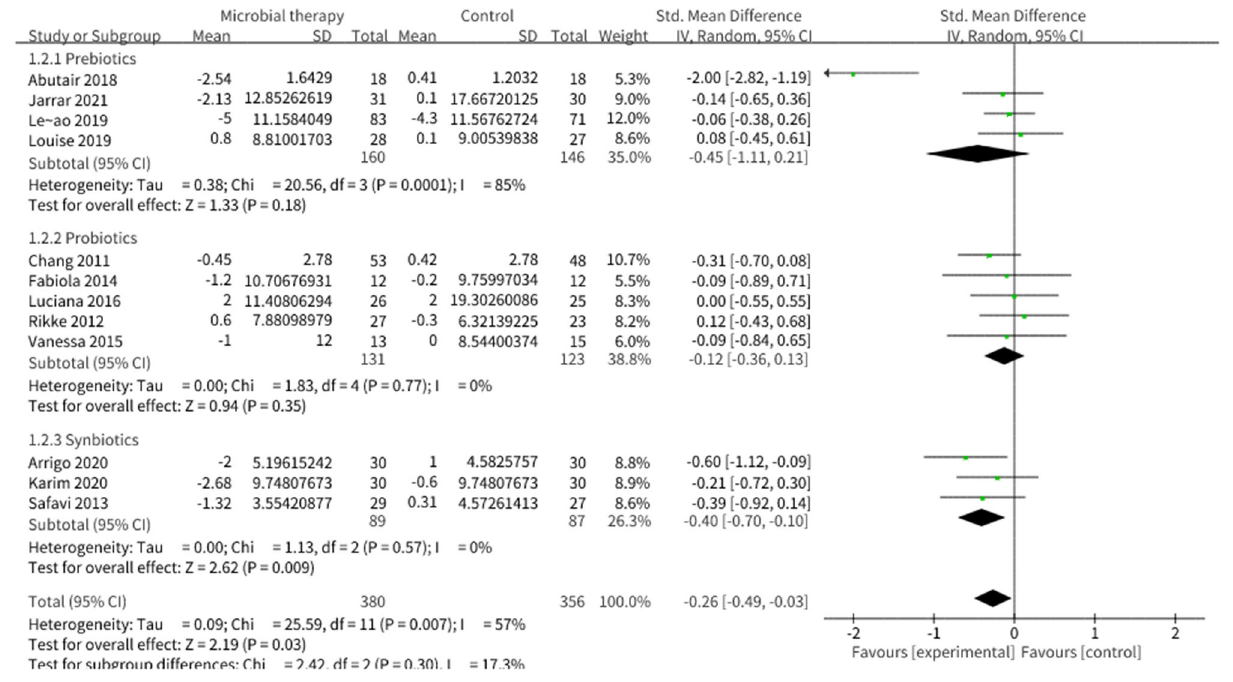
FIGURE 7 | Comparison of SMD of anthropometric parameters between intervention groups and control groupsTau 2 = 0.09, I 2 = 57%, 95% CI − 0.49 to − 0.03, Z = 2.19, p = 0.03. Significant difference was shown in